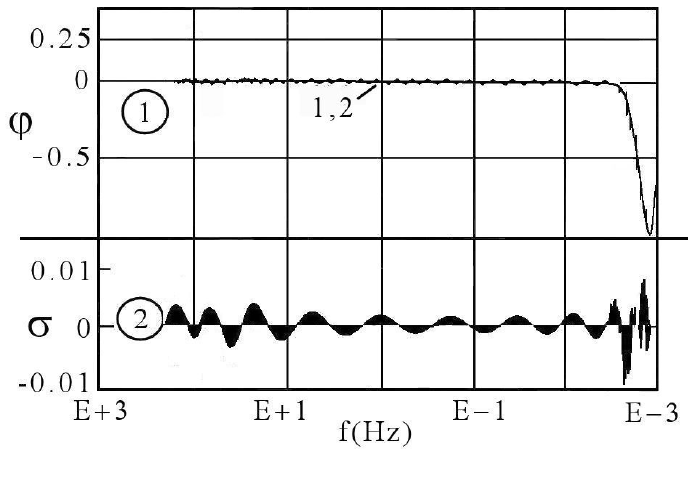
Figure 17. Fourier series polynomial. Envelope of autocorrelation function at reversible potential. Graph ( 1 ): autocorrelation function ϕ , 1,2: overlapped variation of experimental curve and computed model; graph ( 2 ): residual deviation σ